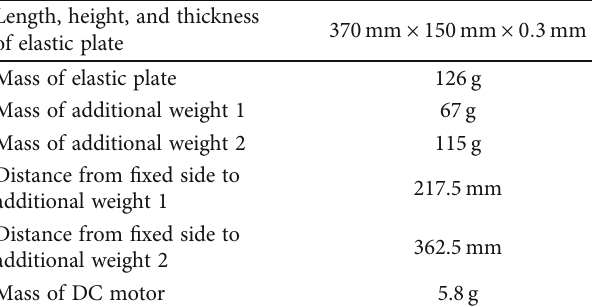
Table 3: Parameters of the experimental apparatus. Length, height, and